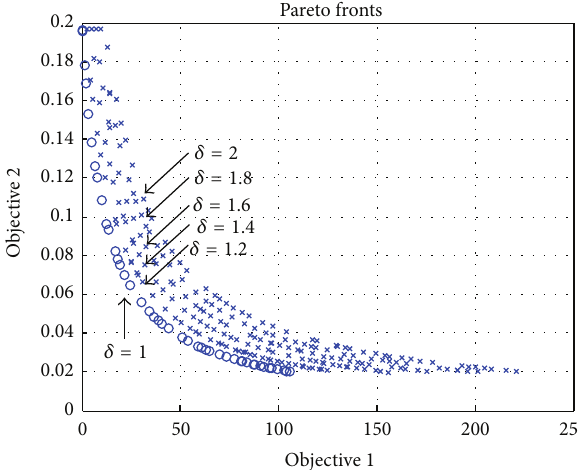
Figure 5: Results of pricing under two conflicting objectives, where Objective 1 is the operator’s profit and Objective 2 is subscribers’ satisfaction.